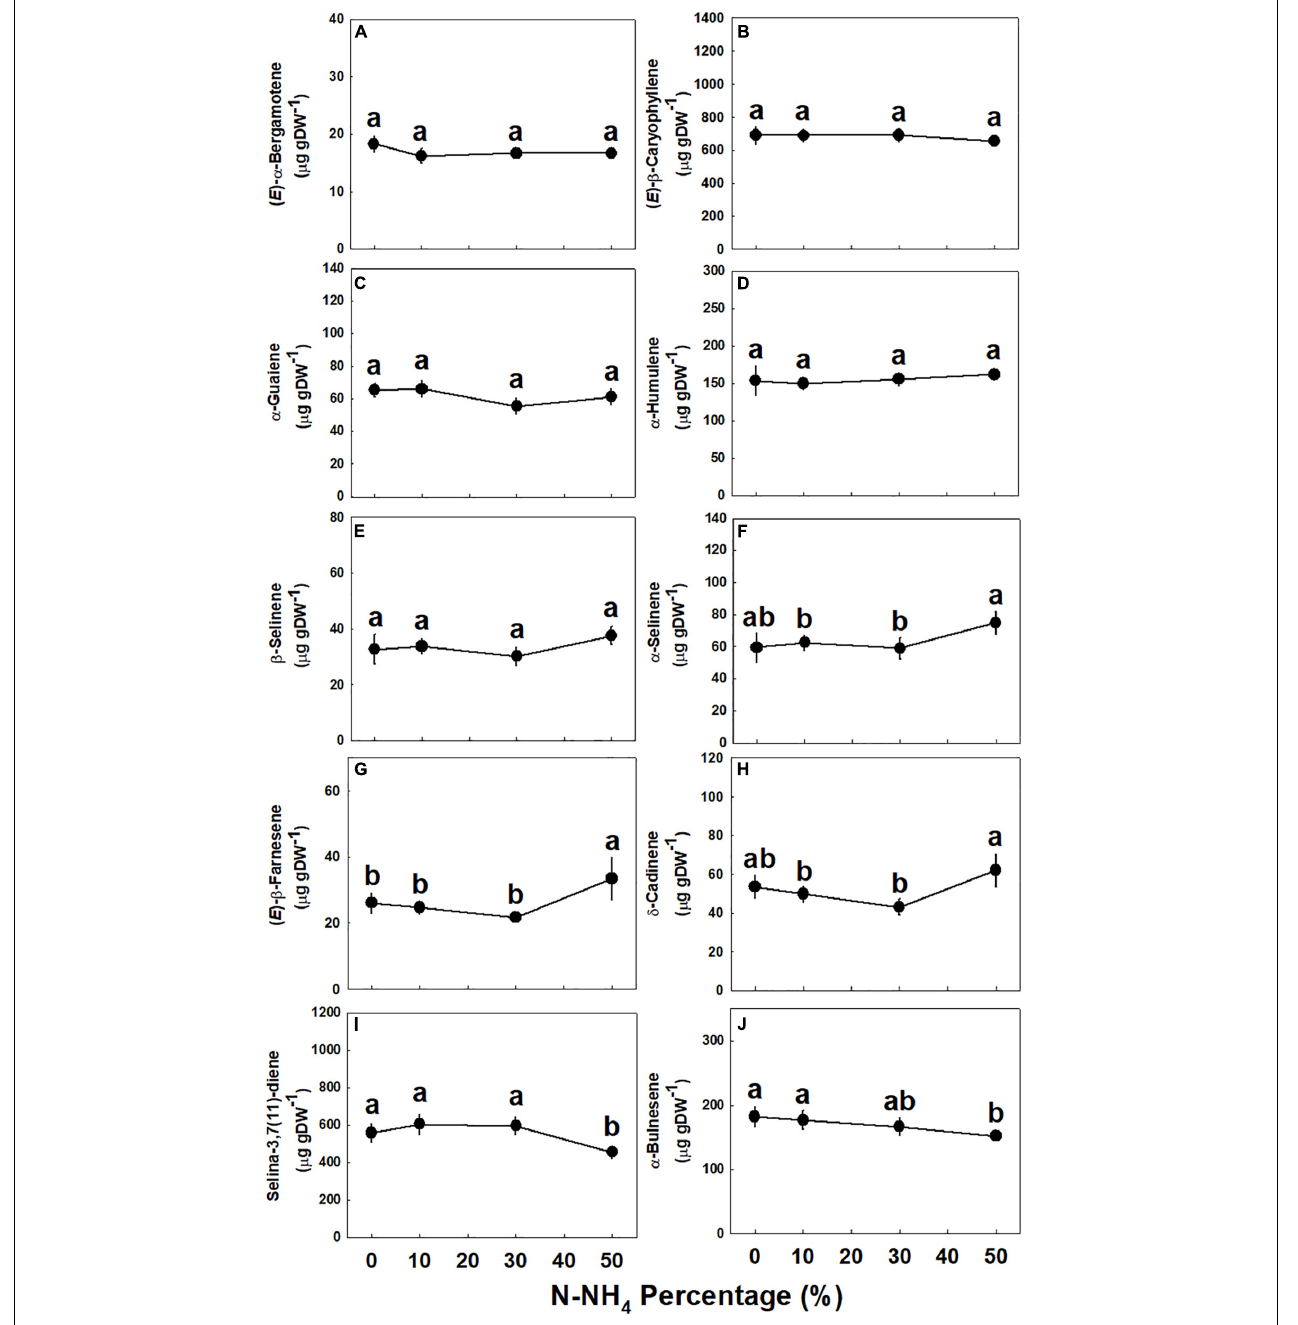
FIGURE 6 | Effect of NH 4 /NO 3 ratio on sesquiterpene concentration in the top inflorescence of medical cannabis plants. ( E )- α -Bergamotene (A) , ( E )- β -caryophyllene (B) , α -guaiene (C) , α -humulene (D) , β -selinene (E) , α -selinene (F) , ( E )- β -farnesene (G) , δ -cadinene (H) , selina-3,7(11)-diene (I) , and α -bulnesene (J) . Presented data are averages ± SE ( n = 5). Different small letters above the means represent significant differences between treatments by Tukey HSD test at α =